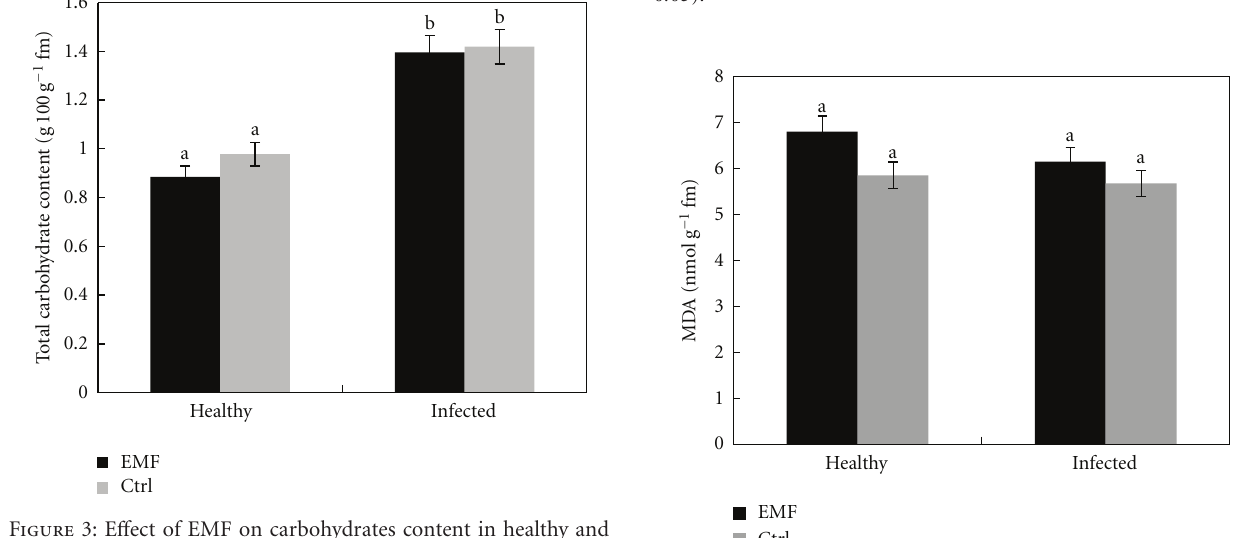
Figure 4: E ff ect of EMF on proline content in healthy and infected plants of Citrus aurantifolia. Vertical bars indicate mean ± SE of three replicates. Di ff erent letters indicate significant di ff erences ( P < 0 . 05).